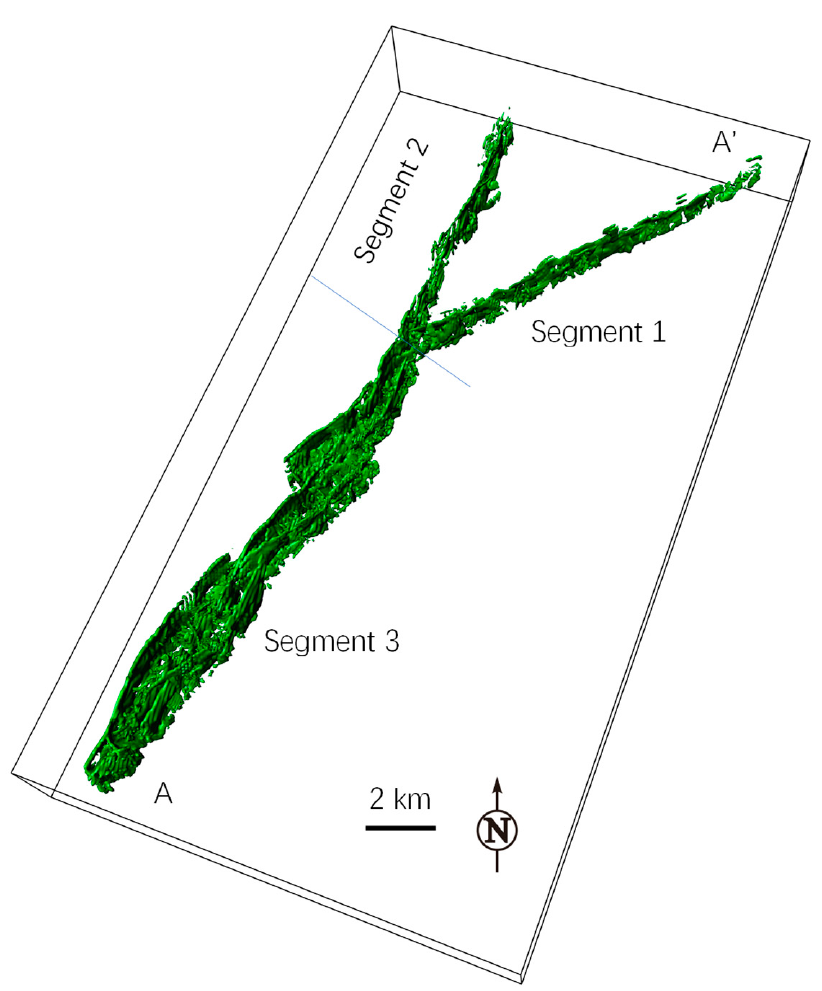
Figure 4. 3D fracture network at top of the Middle Ordovician in the well M1 area (A-A’ showing location in Figure 1).